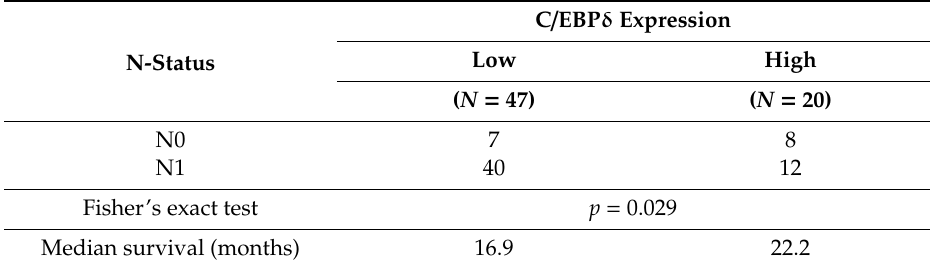
Table 1. N-status correlates to C / EBP δ protein expression in pancreatic ductal adenocarcinoma